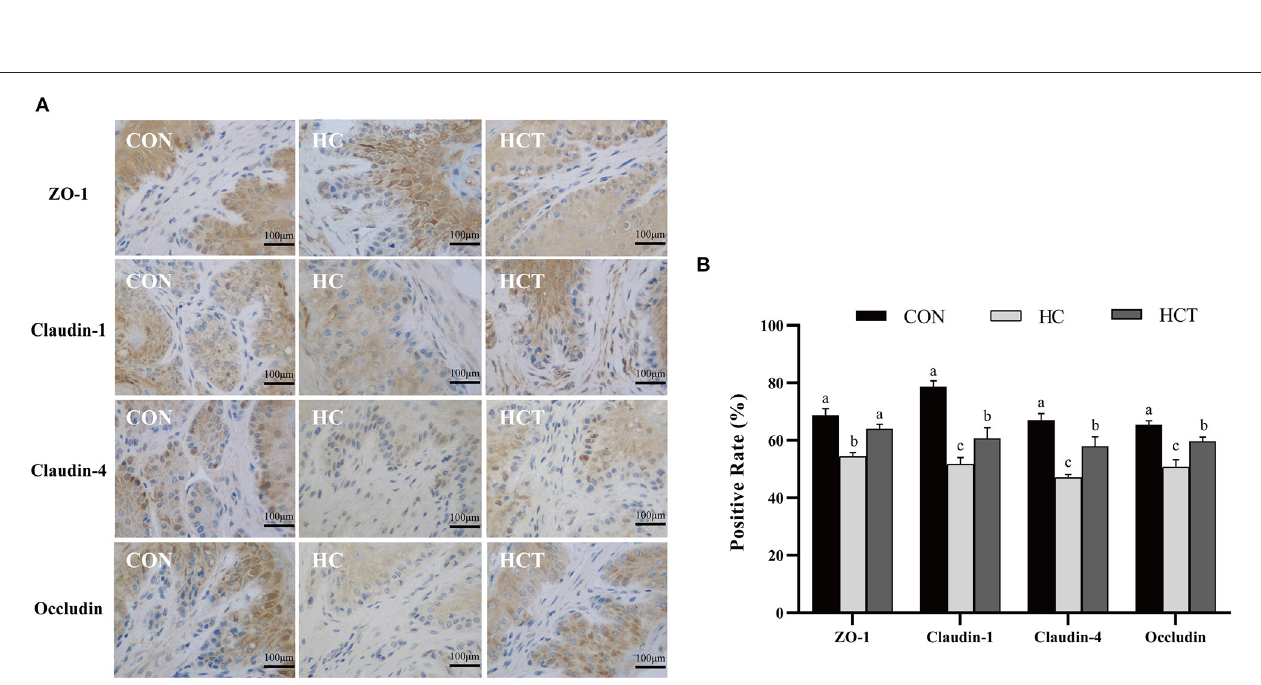
FIGURE 5 | Effects of dietary thiamine supplementation on the expression and distribution of tight junction proteins during HC diet feeding. (A) Immunohistochemistry analysis of ZO-1, claudin-1, claudin-4, and occludin in the ruminal epithelium. (B) Positive rate analysis. All scale bars represent 100 µ m ( n = 8 goats/treatment). CON, low-concentrate diet; HC, high-concentrate diet; HCT, high-concentrate diet supplemented with 200mg of thiamine/kg of dry matter intake. The mean values in columns without a common superscript letter differ ( P < 0.05).